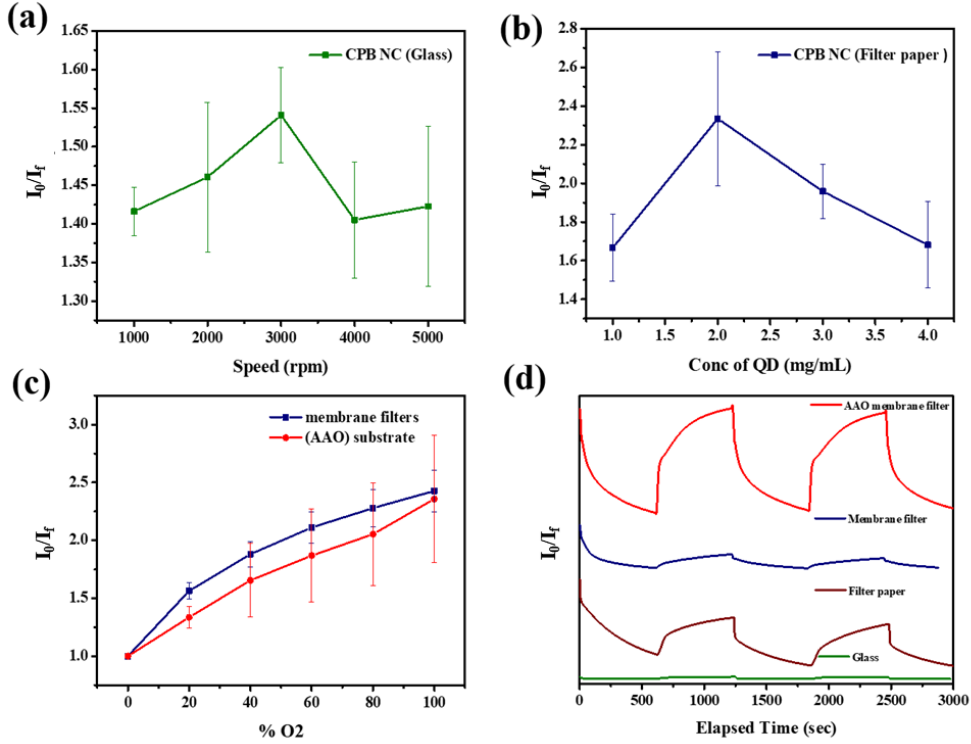
Figure 6. The different spin speed on the device sensitivity. The sensitivities of the sensors fabricated from ( a ) glass and ( b ) filter paper varies with the concentration of CsPbBr 3 solutions. ( c ) The sensitivity of the membrane filters with pore sizes of ~2 µm and 200 nm (Anodic aluminum oxide (AAO) substrate) as the sensor substrates. ( d ) The response and recovery behaviors of all the devices.